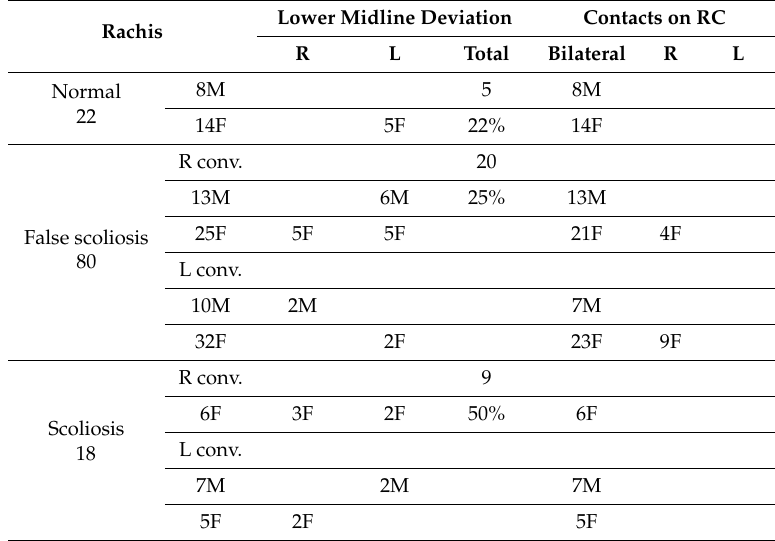
Table 2. Relations between scoliosis and lower midline deviation and contacts on RC in our